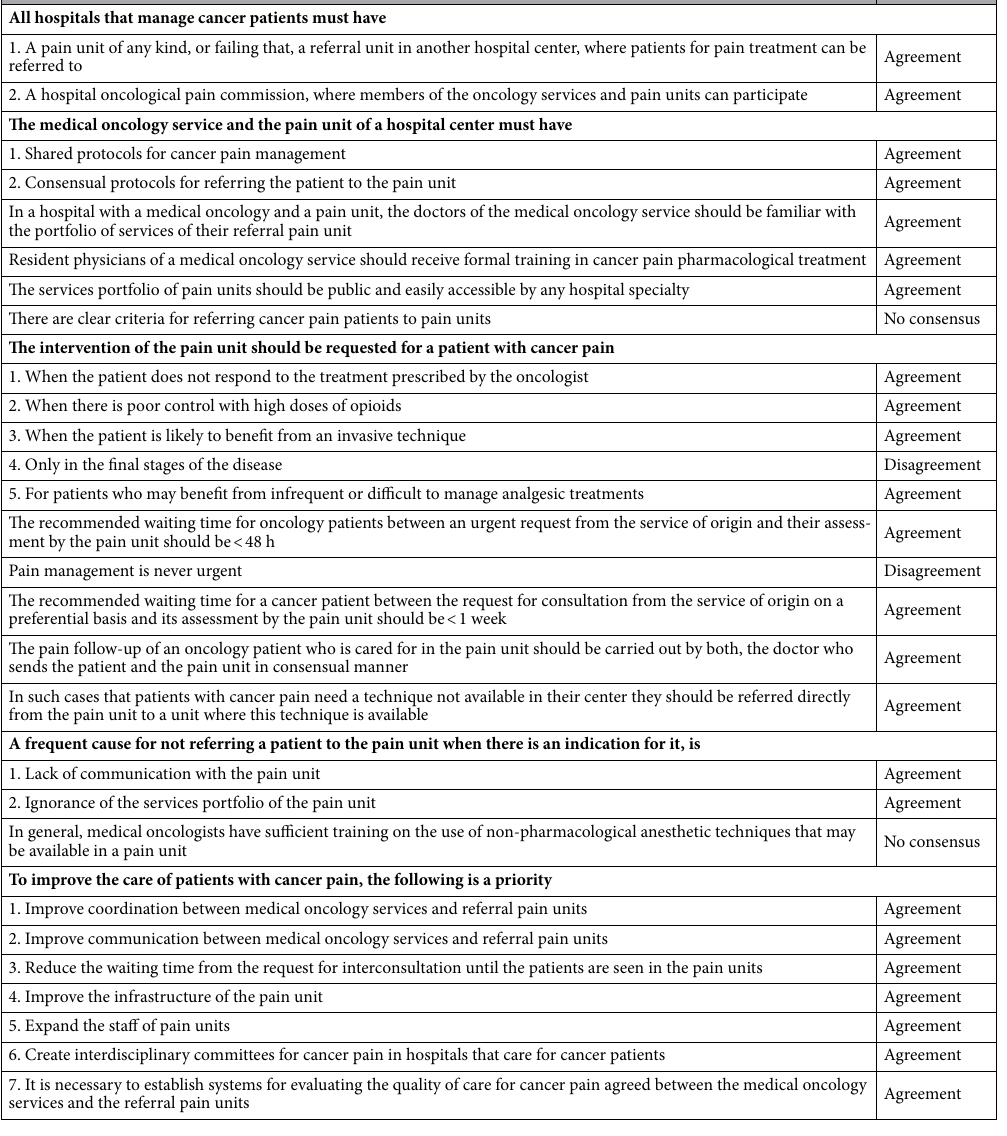
Table 4. Results with maximal